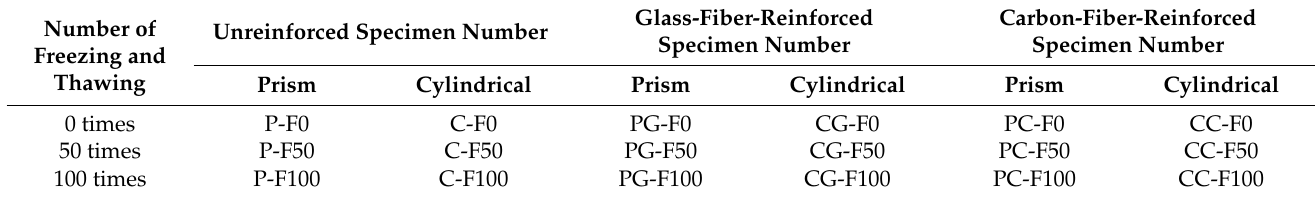
Table 3. Prismatic specimens